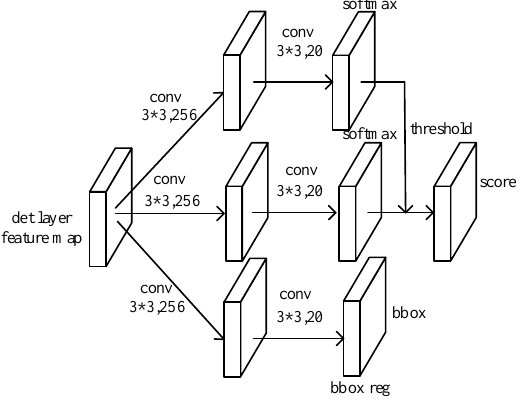
Figure 9. The structure of the detection